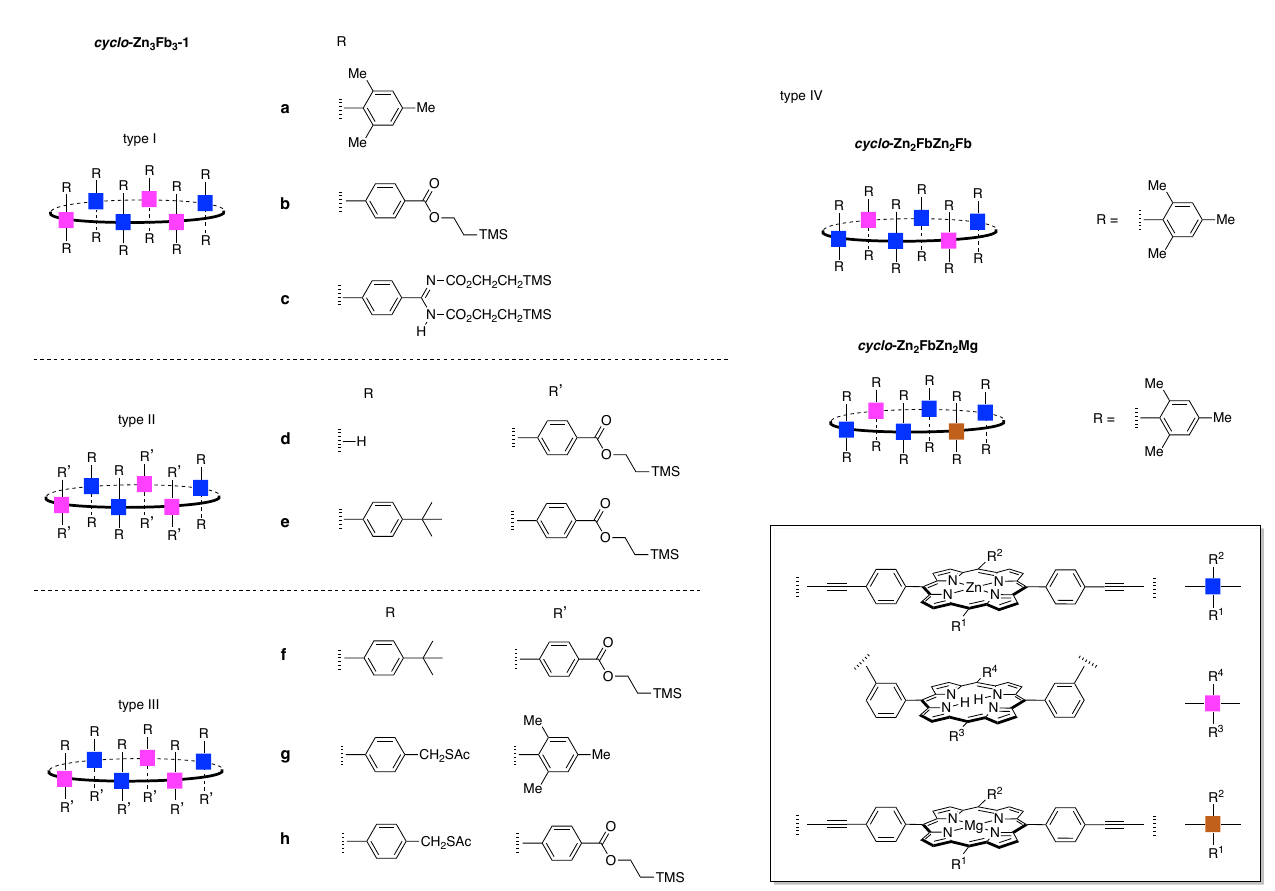
Figure 74. Diverse shape-persistent macrocycles with control over metalation state and peripheral substituents.